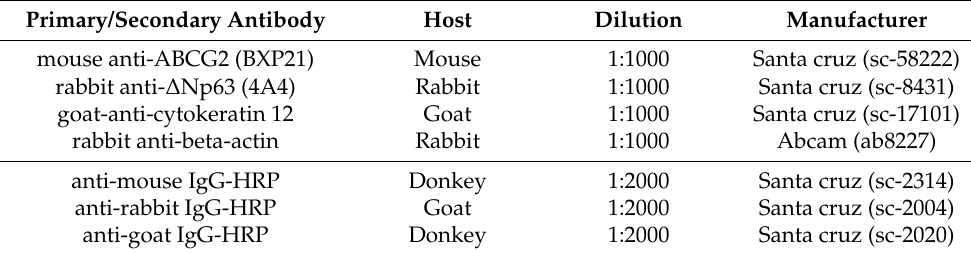
Table 1. List of antibodies and dilutions for Western blot